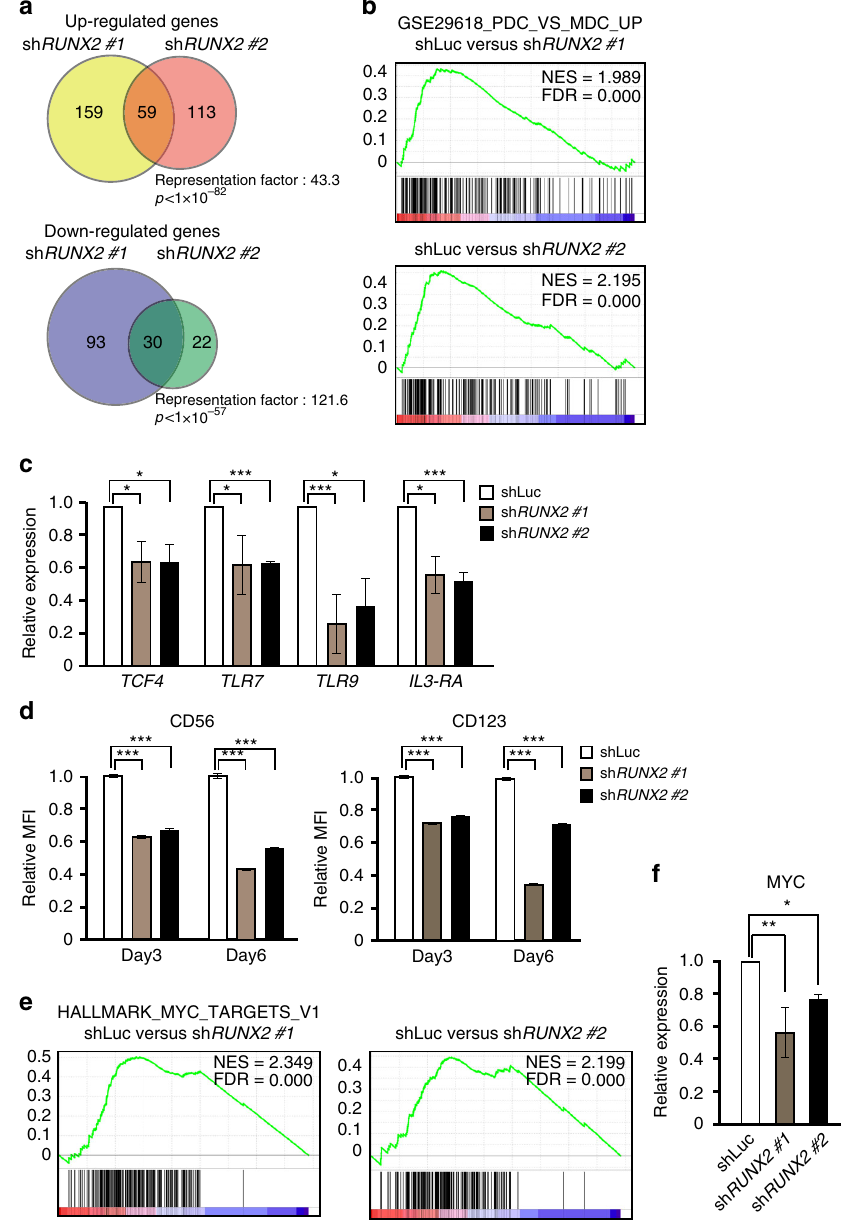
Fig. 3 RUNX2 functions as a lineage-speci fi c transcription factor in BPDCN. a Venn diagrams of signi fi cant overlaps in up-regulated and down-regulated genes between two distinct RUNX2 KD CAL-1 cells relative to control CAL-1 cells. b GSEA for pDC signature genes, which was de fi ned by up-regulated genes in normal pDCs versus mDCs (GSE29618), in two RUNX2 KD CAL-1 cells relative to control CAL-1 cells. c q-PCR showing the reduced expression of pDC signature genes, such as TCF4 , TLR7 , TLR9 , and IL3-RA , in RUNX2 KD CAL-1 cells (gray and black bars). d Decreased mean fl uorescence intensities (MFI) of CD56 and CD123/IL3-RA expression in RUNX2 KD CAL-1 cells (gray and black bars) 3 and 6 days after transduction examined by FACS ( n = 3). e GESA for canonical MYC target genes (Hallmark MYC targets V1) in two RUNX2 KD CAL-1 cells relative to control CAL-1 cells. f Expression levels of MYC mRNA examined by q-PCR in RUNX2 KD CAL-1 cells (gray and black bars) and control CAL-1 cells (opened bar). c , d , f Bars show the mean±SD, * p < 0.05,** p < 0.01, and *** p < 0.001 by the Student ’ s t -test. Data are representative of three independent